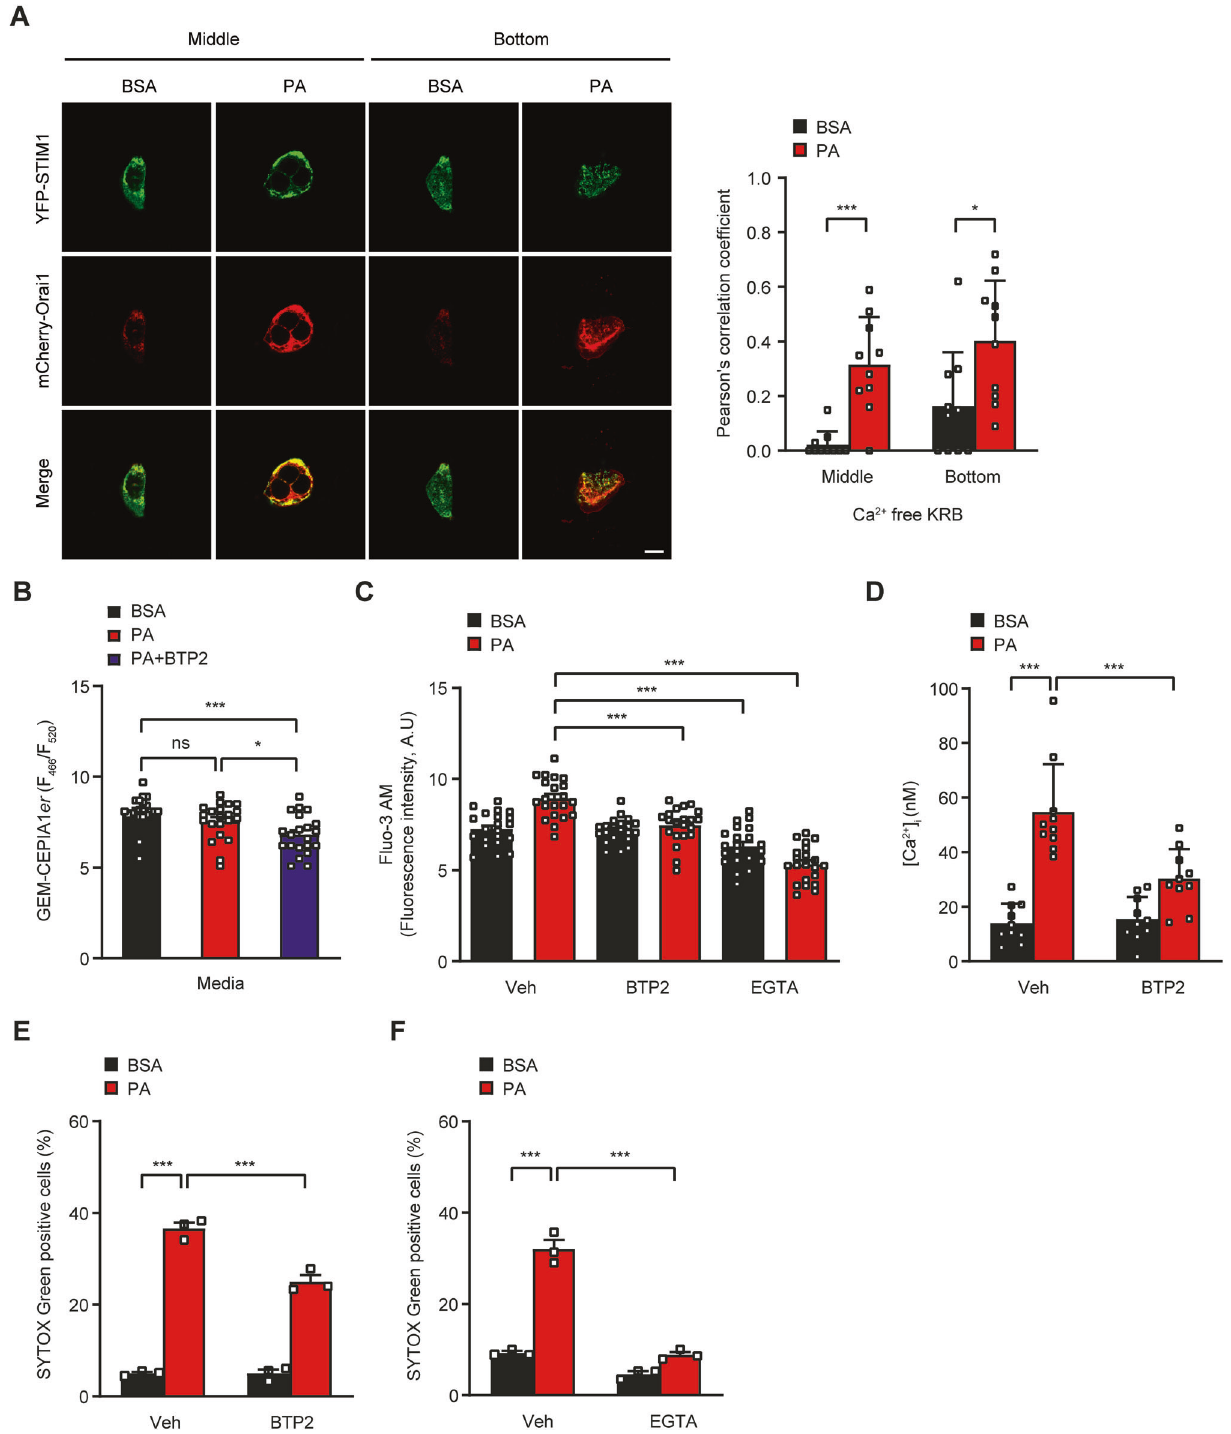
Fig. 4 SOCE in lipotoxicity. A After treatment of HepG2 cells transfected with YFP-STIM1 and mCherry-Orai1 with PA for 6 h, STIM1 aggregation and its co-localization with ORAI1 were examined at the middle and bottom of the cells by confocal microscopy (left). Scale bar, 10 μ m. Pearson ’ s correlation coef fi cient was calculated as an index of co-localization of YFP-STIM1 and mCherry-Orai1 (right). B After treatment of GEM-CEPIA1er -transfected cells with PA in the presence or absence of 10 μ M BTP2 for 6 h, [Ca 2 + ] ER was determined by confocal microscopy. C , D After the same treatment as in ( B ), [Ca 2 + ] i was determined by confocal microscopy after Fluo-3 AM loading ( C ) or ratiometric analysis after Fura-2 loading ( D ). E , F After treatment of cells with PA in the presence or absence of 10 μ M BTP2 ( E ) or 2 mM EGTA ( F ) for 24 h, cell death was evaluated using SYTOX Green. Data are expressed as the means ± SD of three independent experiments. Statistical comparisons were performed using two-tailed Student ’ s t -test ( A ) or one-way ANOVA with Tukey ’ s multiple comparison test ( B – F ). (* P < 0.05; ** P < 0.01; *** P < 0.001; ns not signi fi